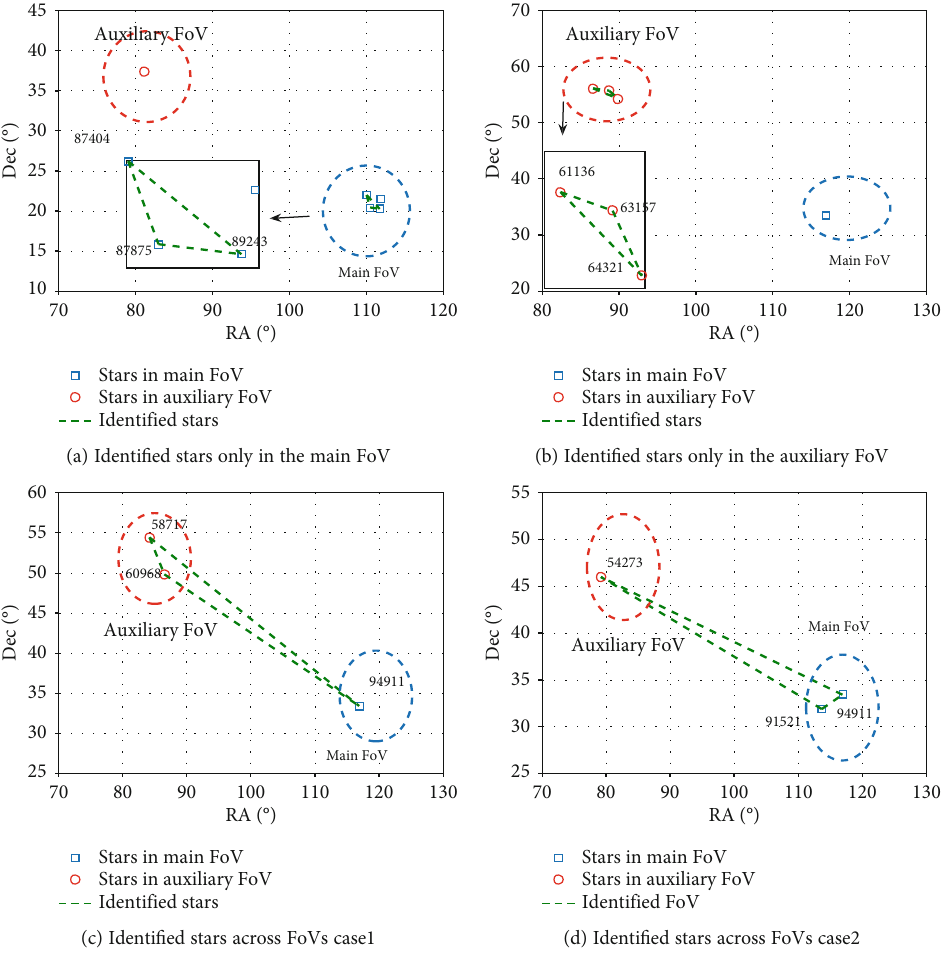
Figure 18: Four kinds of epoch for matching.